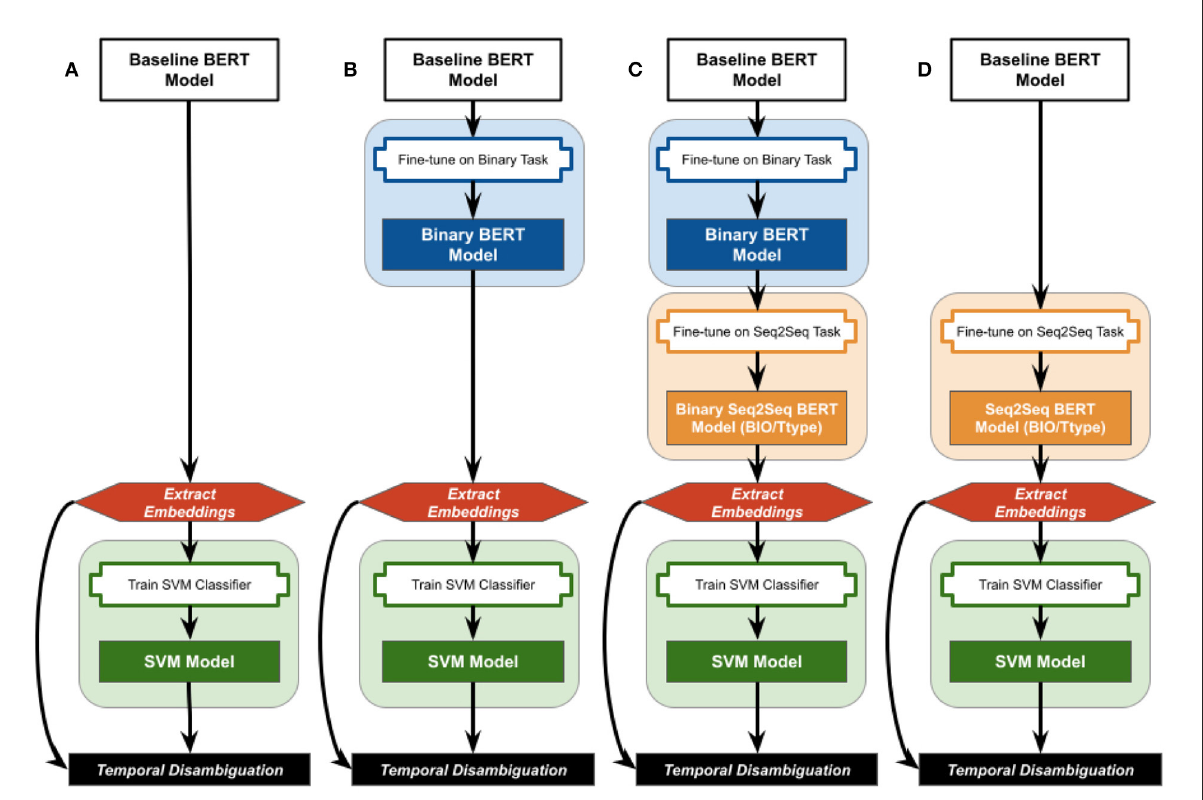
FIGURE1 Overview of the fine-tuning, embedding extraction, and classification strategies examined in this work. Baseline BERT models are either the BertBase or ClinBioBert models referenced in the text. (A) No fine-tuning; (B) binary fine-tuning; (C) sequential Binary-Seq2Seq fine-tuning; (D) Seq2Seq